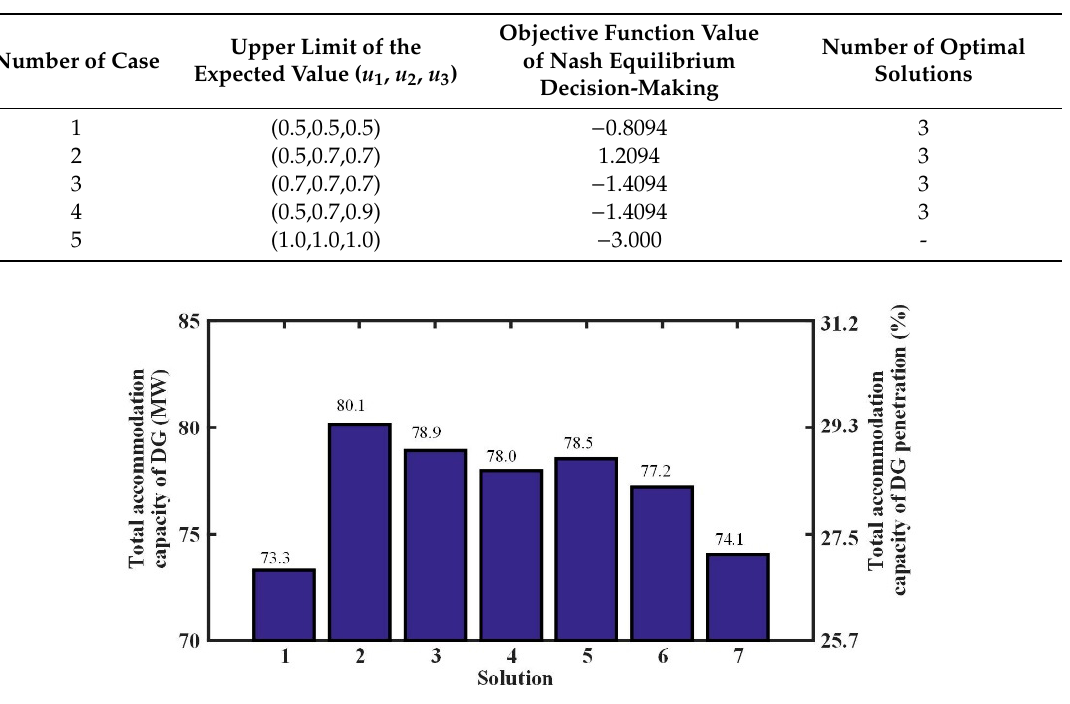
Figure 6. The total accommodation capacity of DG corresponding to the Pareto frontier solution set. The specific PV and WF accommodation capacities of each node to be built under two di ff erent is scattered. Thus, the total DG accommodation capacity of the distribution network in this area could be maximized on the premise of ensuring the flexibility of the distribution network, in which several nodes do not need to connect large-capacity DG equipment. In scene B, the actual accommodation capacity of the PV nodes to be built is larger and more centralized than for the corresponding nodes in scene A.